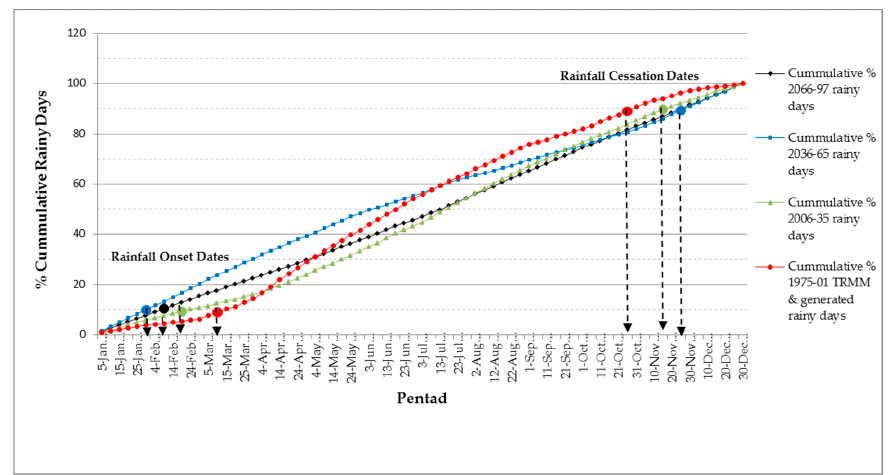
Figure 9. Kaabong Future Mean Rainfall Onset and Cessation for Rainy Days (TRMM rainfall (1975– 2001) and projected (HadCM3) 2006–2035, 2036–2065 and 2066–2099).